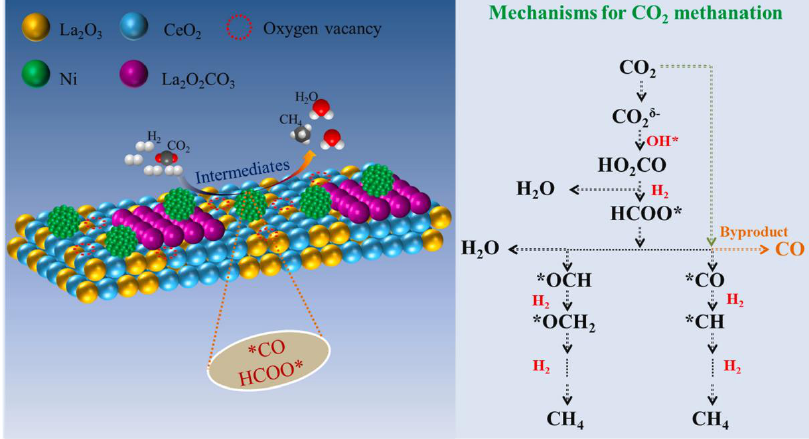
Figure 32. The main CO 2 methanation route over Ni/CeO 2 -La-600, where CeO 2 -La-600 denotes La species introduced into CeO 2 support and calcined at 600 °C. Reproduced with permission from